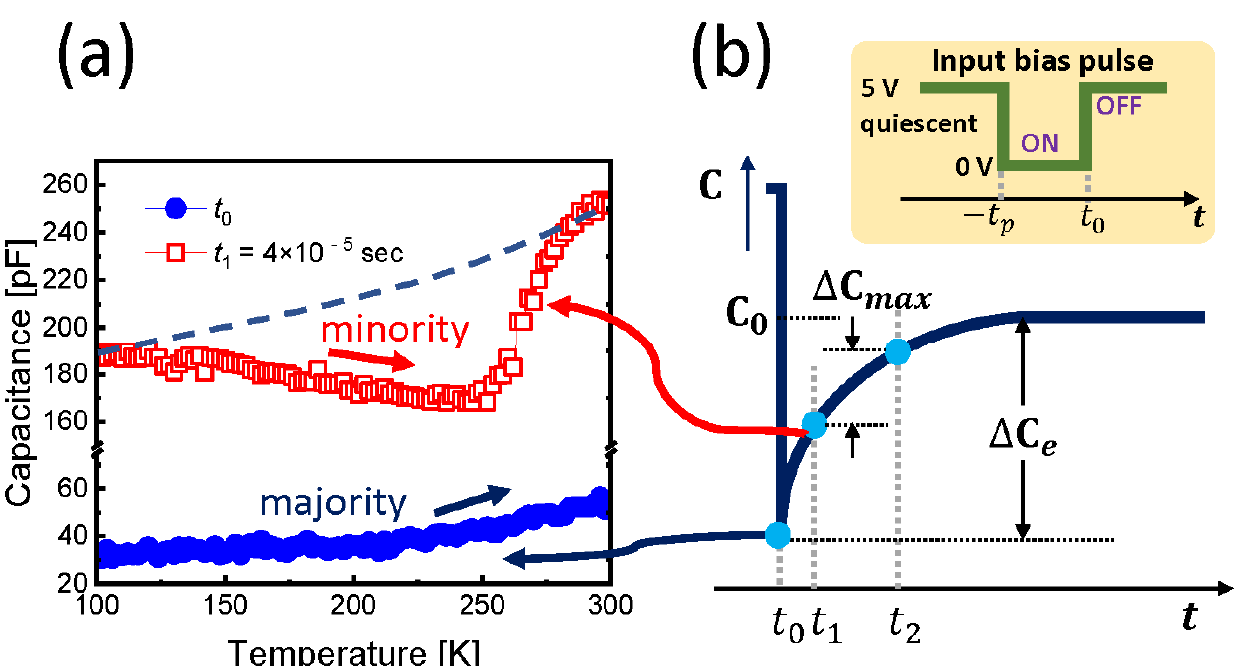
Figure 3. ( a ) TSCAP data in the time t 0 and t 1 = 4 × 10 − 5 s. The dashed guideline indicates the expected capacitance in the case of the majority carrier. Capacitance decrease with the temperature in the case of t 1 means that the minority carrier generation is dominant, which correctly coincides with the case of the majority carrier emission (i.e., hole emission) at the deep trap level. Note that here a TSCAP-like measurement was considered at the specific time of the capacitance transient process after the pulse edge time t 0 at ( b ). t 1 , and t 2 are within 10 − 4 s at the filling pulse time t p = 50 m sec in our test.